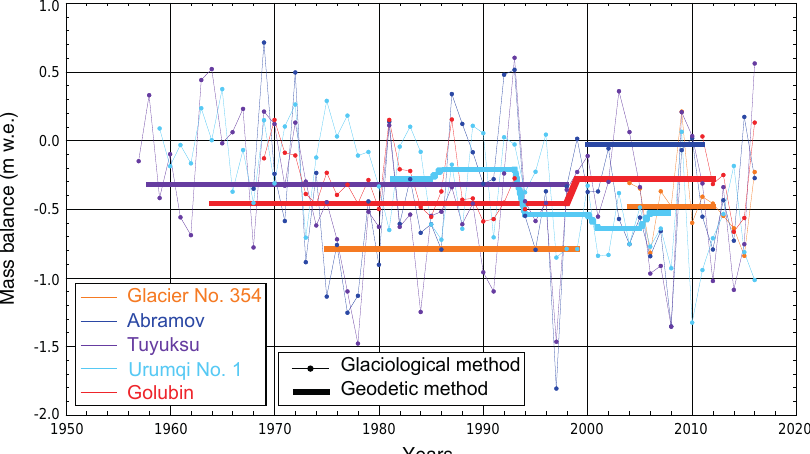
Figure 12. Comparison of glaciological and geodetic mass balance for glaciers in Central Asia. The geodetic mass balances are from Hagg et al. (2004) (Tuyuksu), Wang et al. (2014) (Urumqi Glacier No. 1), Pieczonka and Bolch (2015) and Kronenberg et al. (2016) (Glacier No. 354), and Gardelle et al. (2013) (Abramov). The glaciological data are provided by WGMS